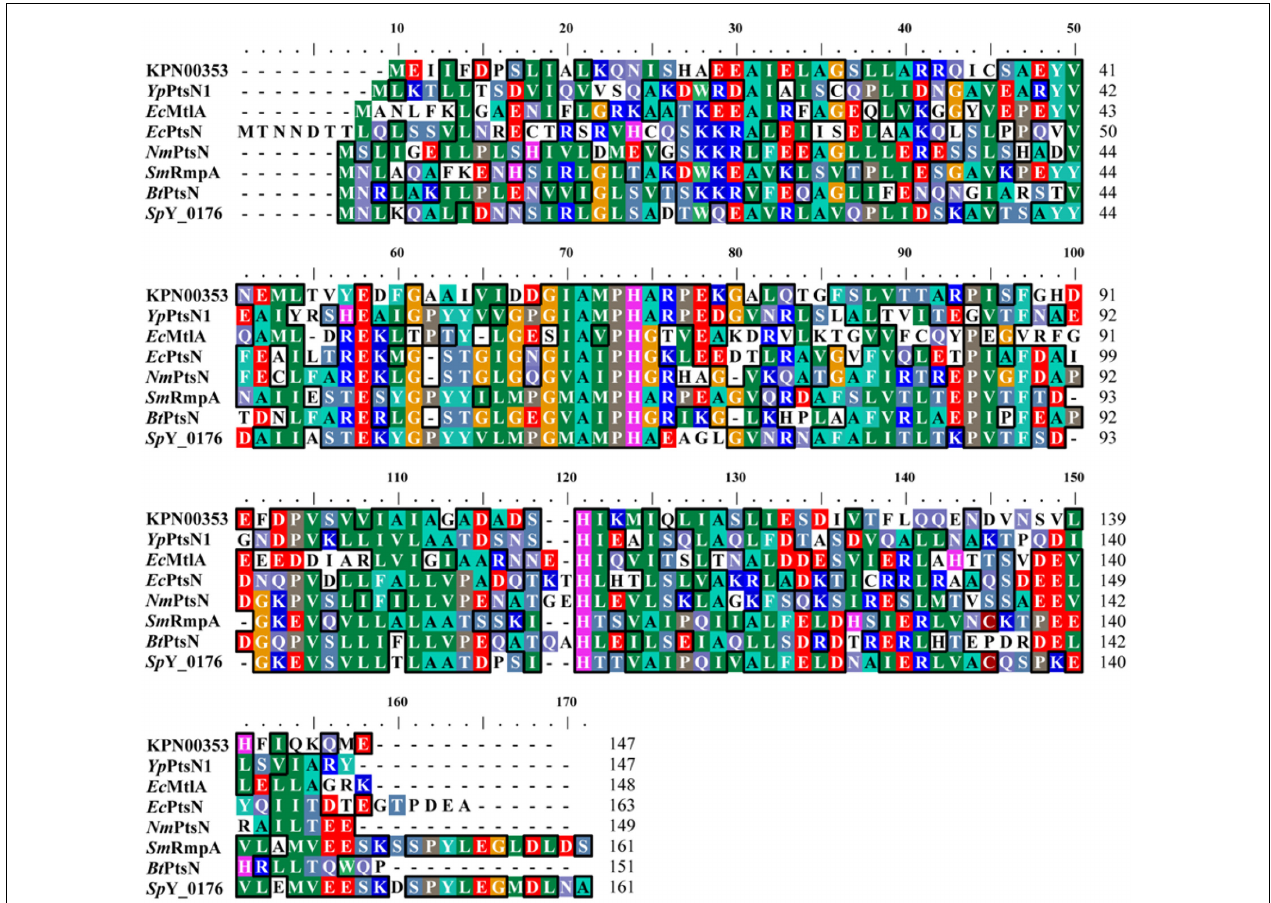
FIGURE 4 | Multiple sequence alignment of PTS-fructose-mannitol EIIA family proteins. Multiple alignment was performed using ClustalW (Thompson et al., 1994; Chenna et al., 2003). Yp PtsN1: Yersinia pestis EIIA Mtl (PDB accession code: 3OXP_A); Ec MtlA: E. coli EIIA Mtl (PDB accession code: 1A3A_A); Ec PtsN: E. coli EIIA Ntr (PDB accession code: 1A6J_A); Nm PtsN: Neisseria meningitides EIIA Ntr (PDB accession code: 2A0J_A); Sm RmpA: Streptococcus mutans PTS IIA fructose superfamily (PDB accession code: 3BJV_A); Bt PtsN: Burkholderia thailandensis EIIA Ntr (PDB accession code: 3URR_A); and Sp Y_0176: Streptococcus pyogenes PTS IIA fructose superfamily (PDB accession code: